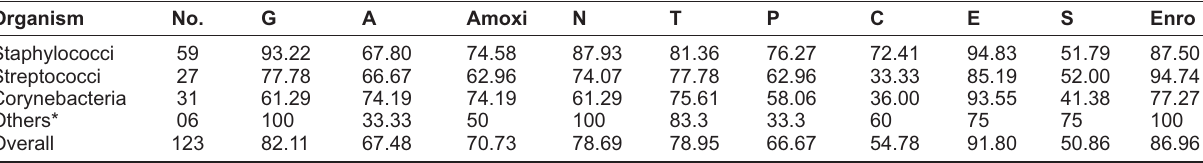
Table-3: Cultural Sensitivity pattern of the bacterial species isolated from cases of specific mastitis.